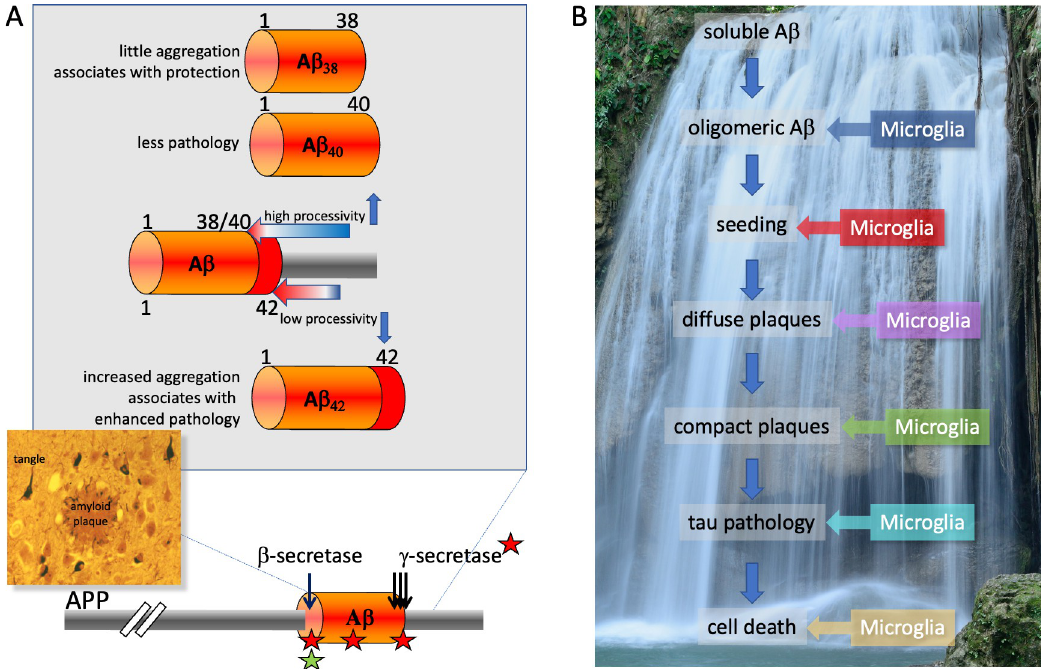
Fig 1. A β can trigger AD. ( A ) Proteolytic processing of APP by β -secretase and γ -secretase leads to the generation of A β protein. Red asterisks: mutations that cause familial AD; green asterisk: a protective mutation. Insert: typical amyloid plaques and neurofibrillary tangles of AD pathology. ( B ) One way to depict the amyloid cascade. Individual steps in the cascade may evoke distinct microglial responses. A β , amyloid β -protein; AD, Alzheimer disease; APP, amyloid precursor protein.